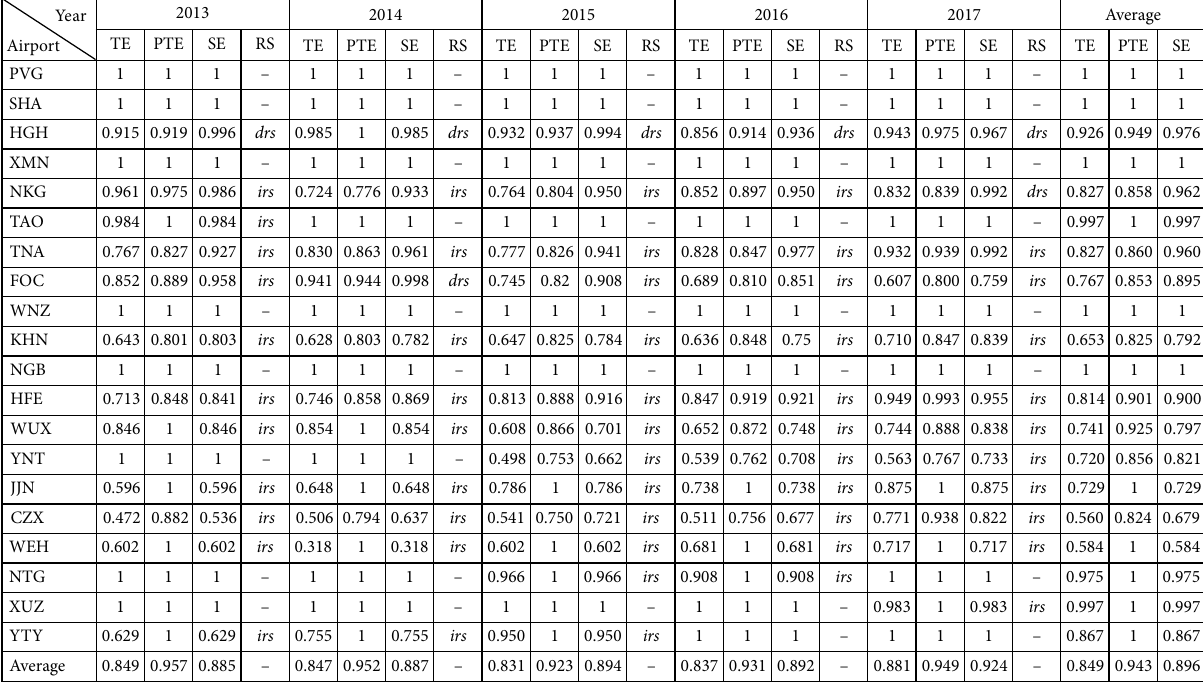
Table 4. Efficiency of the first